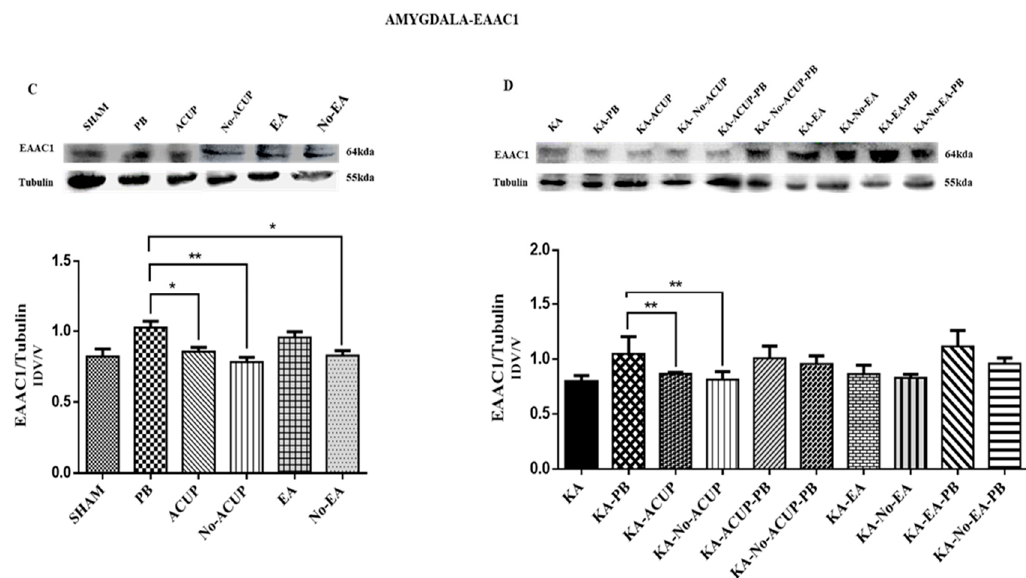
Figure 5. Graph showing the expression of GAD67 in the amygdala. ( A ) The PB group showed an increased GAD67 expression as compared with the ACUP and No-ACUP groups (** p < 0.0034 * p < 0.0722) and with the EA and No-EA groups. ( B ) Experimental groups. KA-PB showed an increase in GAD67 expression as compared with KA-ACUP and KA-No-ACUP groups (* p < 0.0003 and ** p < 0.0001). However, despite showing a significant difference of (*** p < 0.0037, ** p < 0.01) among the groups KA-ACUP-PB as compared with KA group and between the KA-No-ACUP-PB (@ p < 0.0037), it was not observed when compared to the KA-PB group. The KA-EA-PB group showed increased GAD67 expression ( α p < 0.0395) as compared with the KA-ACU-PB group. Additionally, the KA-No-EA, KA-EA-PB and KA-No-EA-PB showed an increase of (# p < 0.001, **** p < 0.0001, β p < 0.0001) as compared to the KA group ( C ) Graph showing EAAC1 expression in the amygdala. PB group, with significantly increased EAAC1 expression as compared with ACUP, No-ACUP (* p < 0.0031) and No-EA (** p < 0.0015) groups. ( D ) Experimental groups. The KA-PB group showed an increased in EACC1 expression as compared with the KA-ACUP and KA-No-ACUP groups (** p < 0.0016). One-way ANOVA followed by a Bonferroni’s post hoc test, p < 0.05.